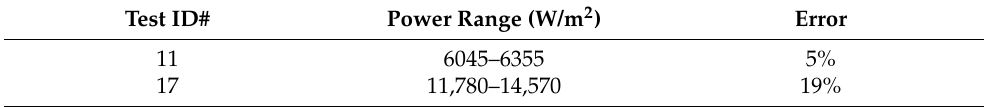
Table 3. Range of Powers and Error between Test